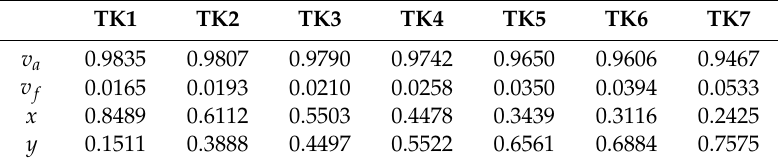
Table 6. Volume fractions of air and fiber, and the fractions of fiber orientation to the heat